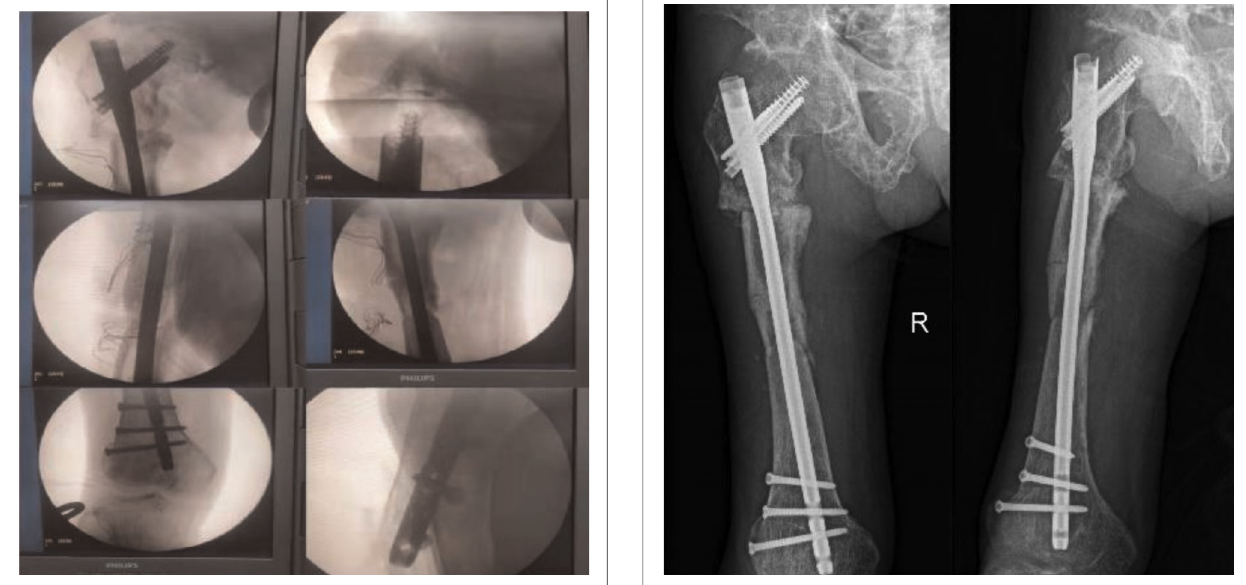
FIGURE 7 | Follow-up 3 months after surgery.